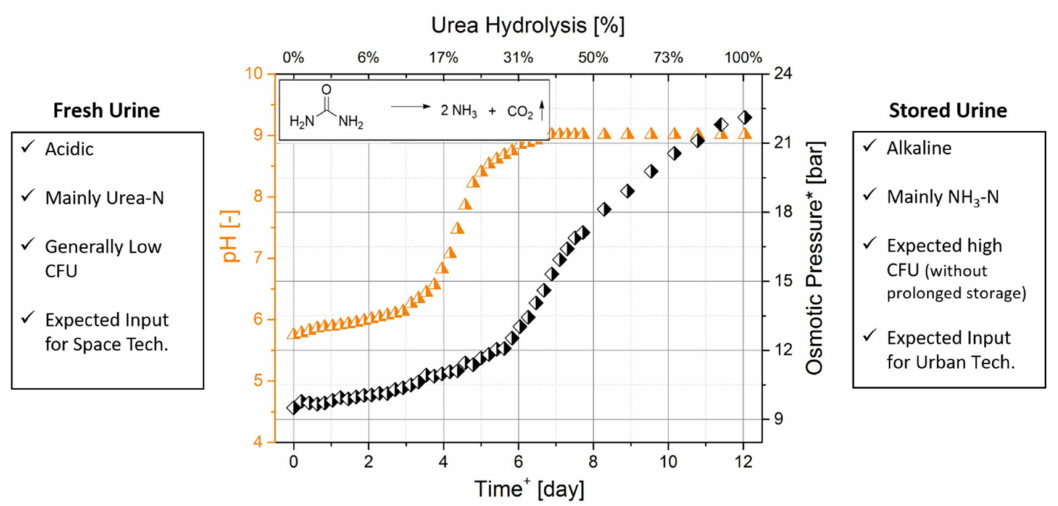
Figure 1. From fresh to hydrolysed. The change in pH and osmotic pressure during urea hydrolysis in the urine. * OLI Studio Analyser software was used to estimate the osmotic pressure based on the chemical analysis of the urine solution. Adapted from Volpin (2019)